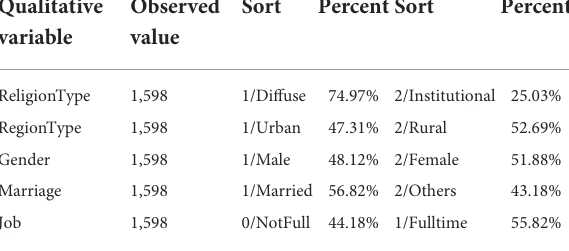
TABLE 2 Descriptive statistics of qualitative variables.